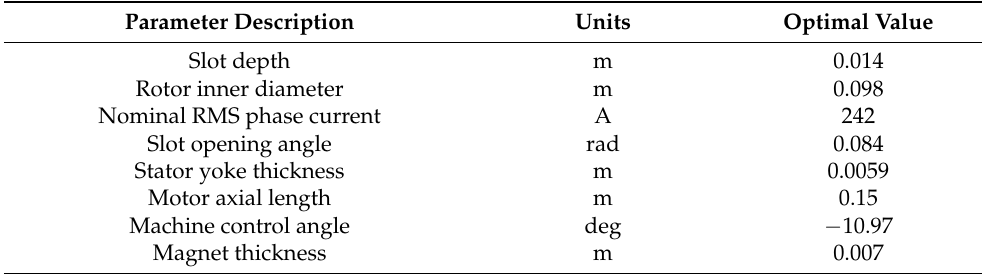
Table 10. Optimal results for FEA.